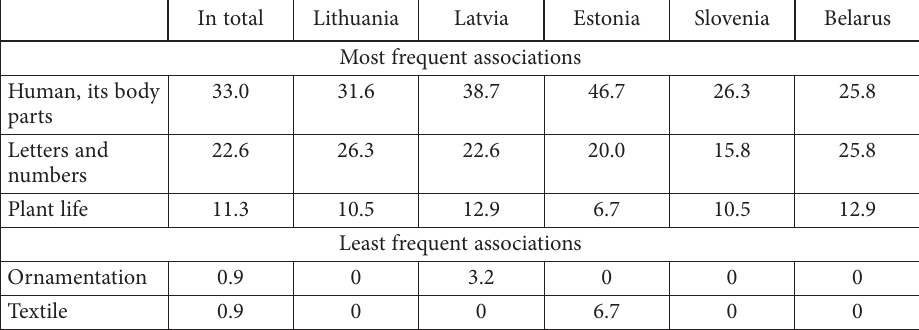
Table 9. Associations of Fragment 5 (%) (source: created by authors) In